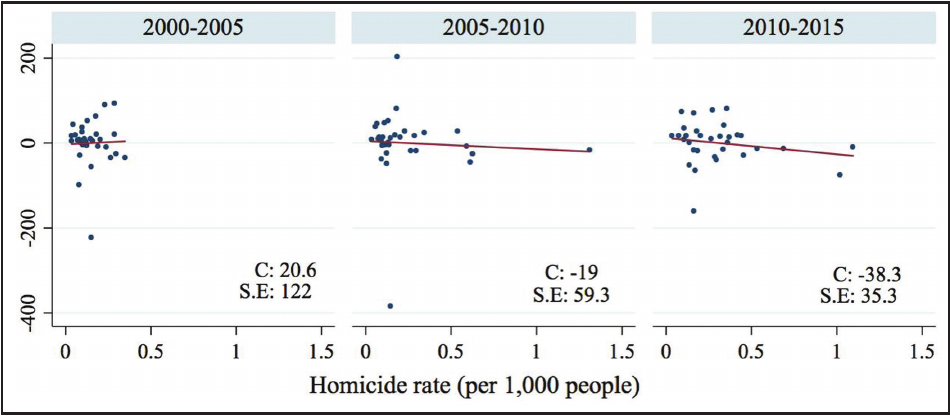
Note : C stands for slope coefficient and S.E. for standard error of fitting curve.